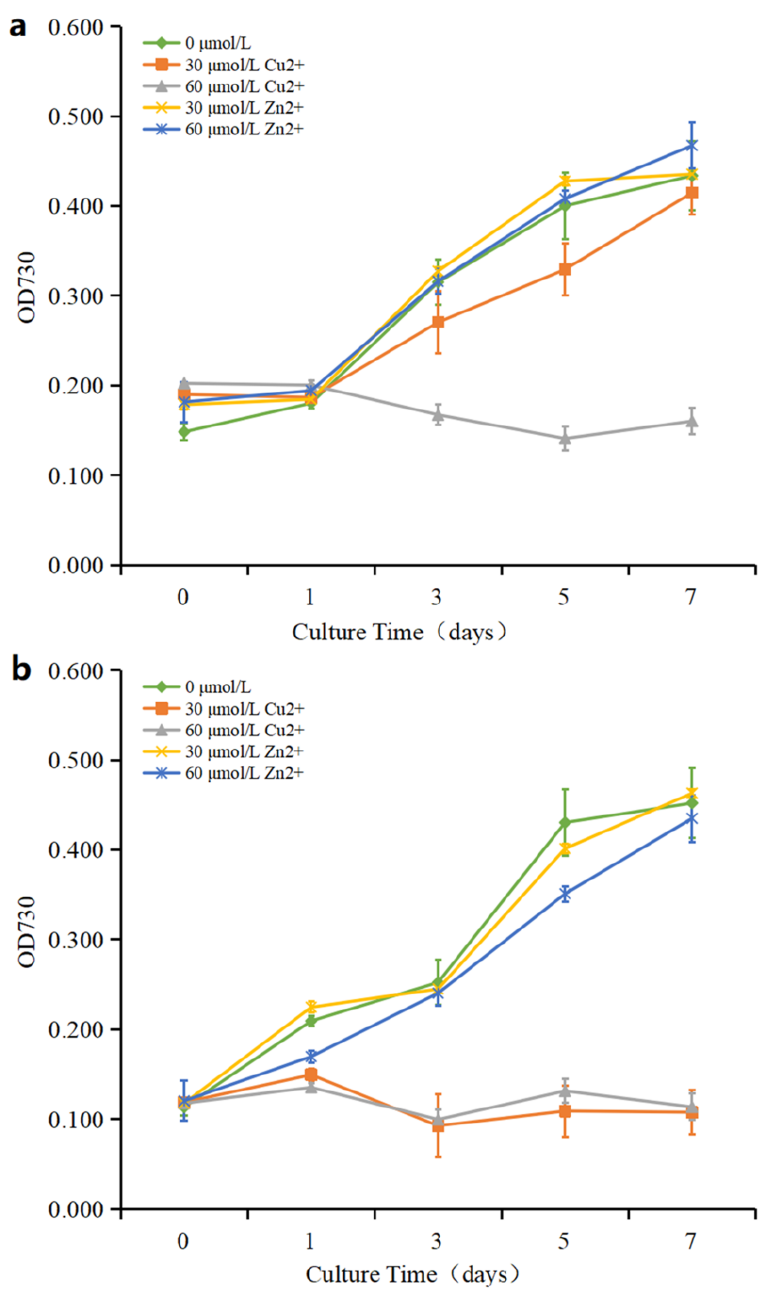
Figure 1. Growth of P. tricornutum ( a ) and C. fusiformis ( b ) under different Cu 2+ or Zn 2+ concentrations (0, 30 and 60 µ M). Data points are the means of triplicates, and error bars represent the standard deviation.